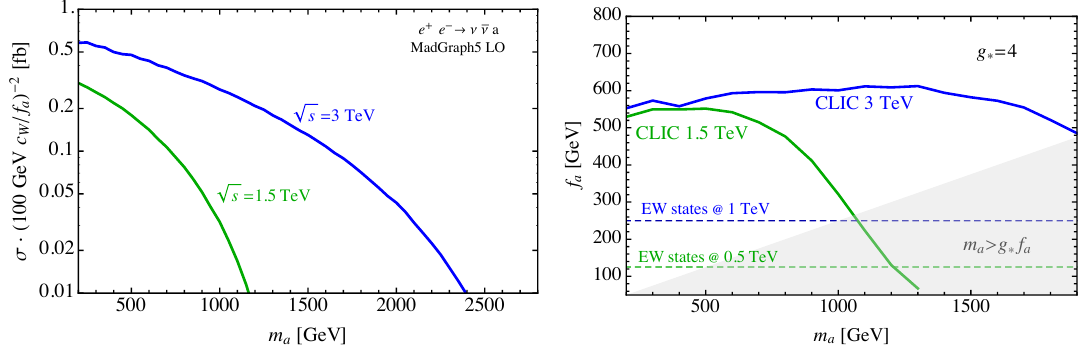
Figure 10. Left: single production via WW -fusion of a photophobic ALP c 1 = (cid:0) 3 = 5 c 2 . Right: reach of CLIC at 1.5 TeV (green ) and 3 TeV (blue) in the photophobic ALP parameter space for g (cid:3) = 4 ( c 2 = 16 (cid:25) 2 =g 2 ). In grey we show the region where m a & g (cid:3) f and the EFT in eq. (4.8) ceases (cid:3) to be justi(cid:12)ed. Dashed lines indicate the scale of the EW states which could be within the reach of CLIC at 1.5 TeV (green) and at 3 TeV